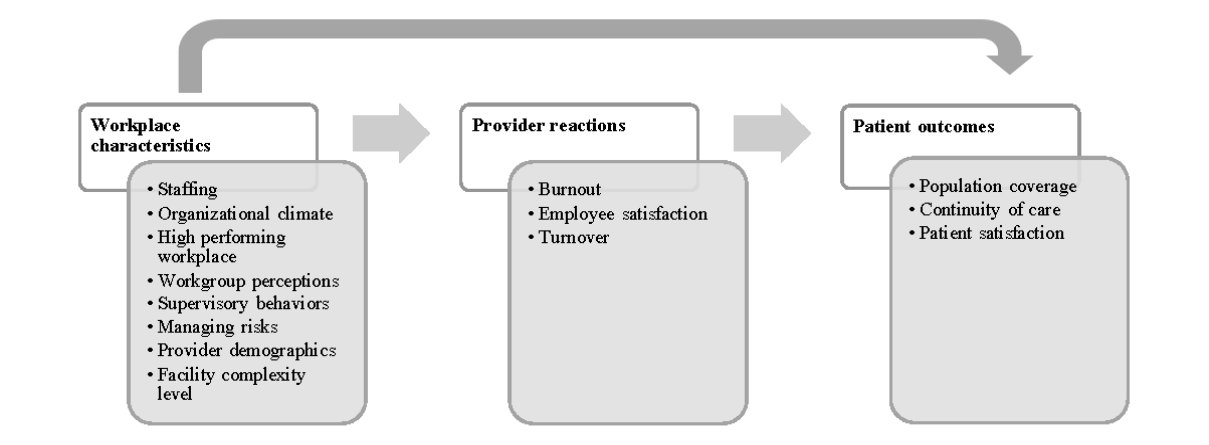
Figure 1. Conceptual